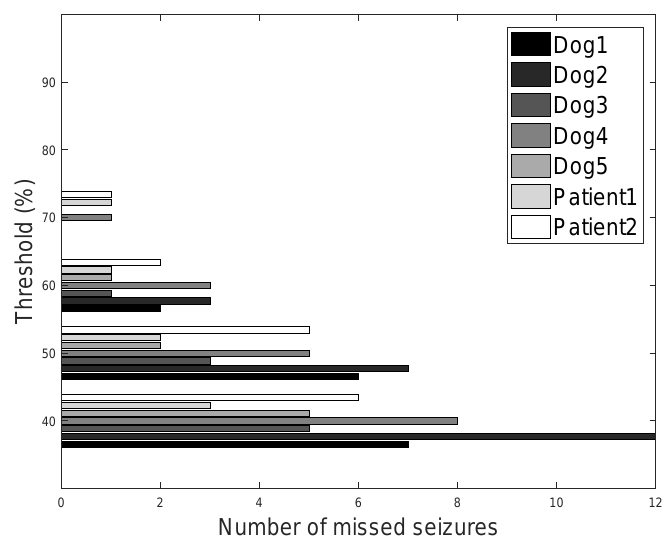
Figure 8. Number of seizure episodes missed from classification as a function of threshold for all dataset.